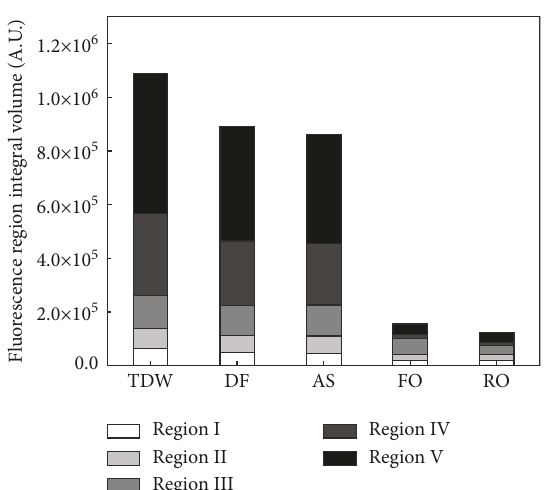
Figure 7: Fluorescence integral volume change of the effluent from different processes.